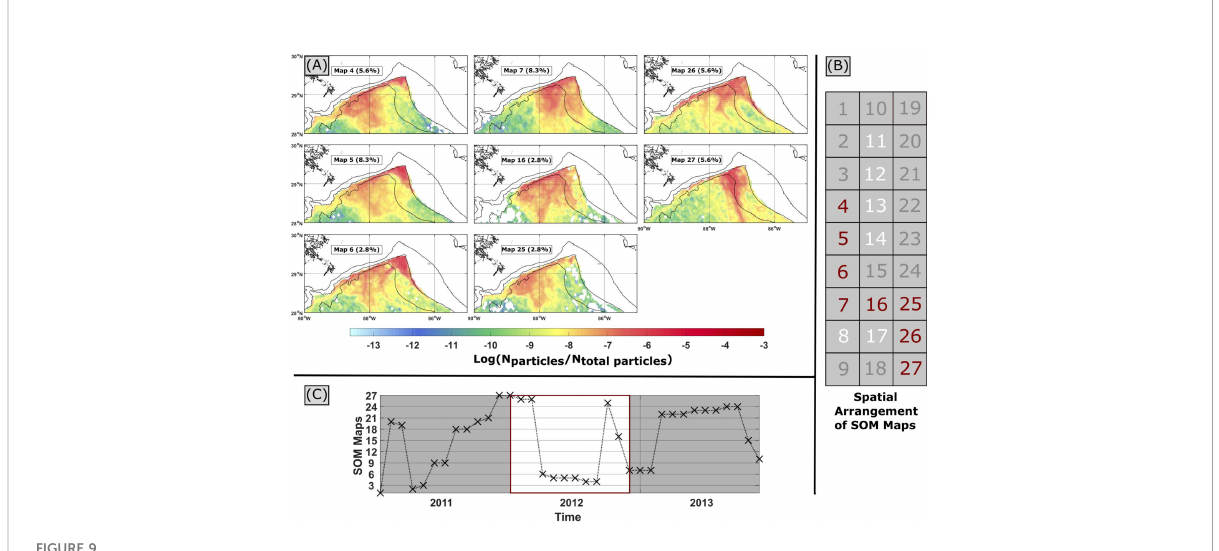
(Figure 14). RAFOS drifter tracks (Figure 2) illustrated how eddies can capture drifters and transport them across isobaths into the basin interior. Based on novel Lagrangian observations we postulate that eddies transport particles away from depth- constrained along-slope pathways, affecting their dispersion and residence times in the eastern GoM. To draw together the larger-scale consequences of the eddy northeastern GoM, which means that fl ow at 400 m depth in